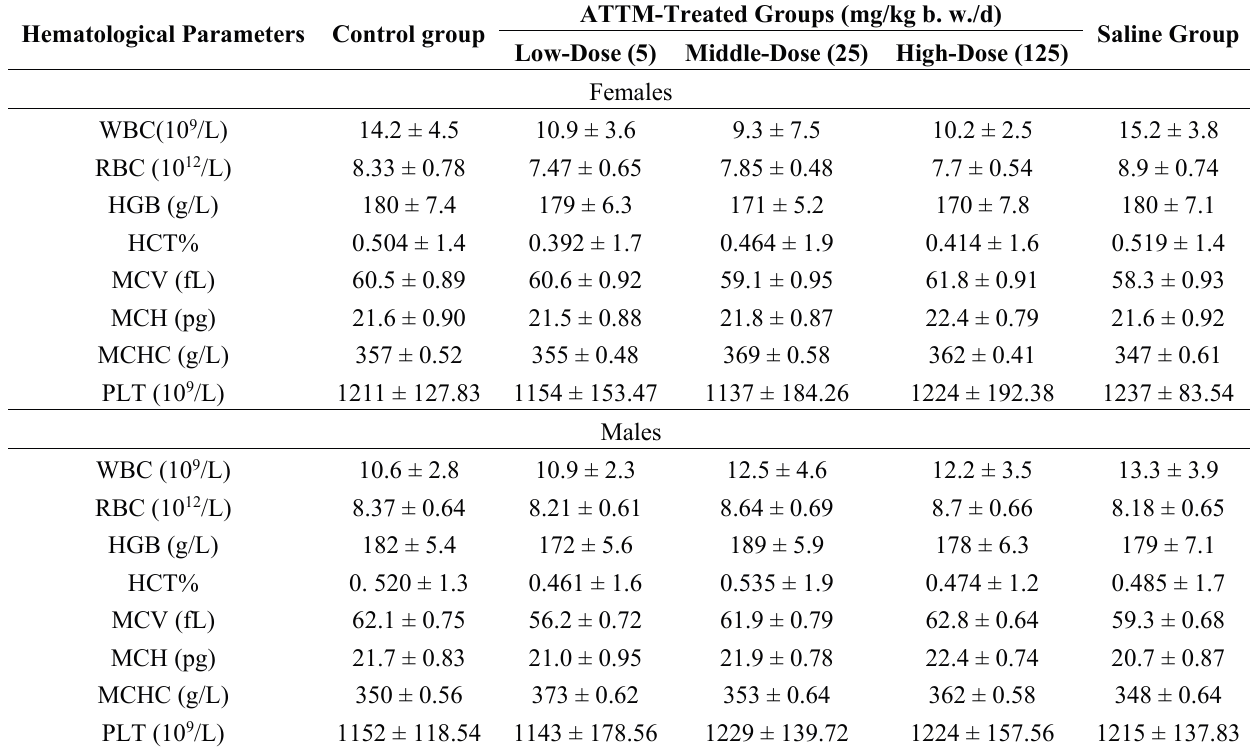
Table 4. Hematological findings in rats orally administered ATTM for 28